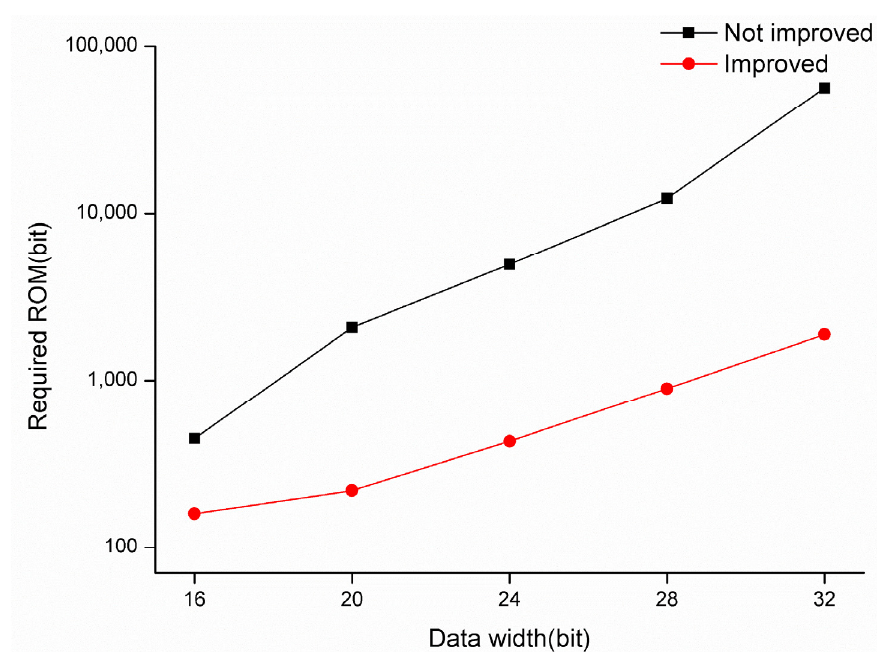
Figure 8. ROM resources required at different bit widths before and after optimization.